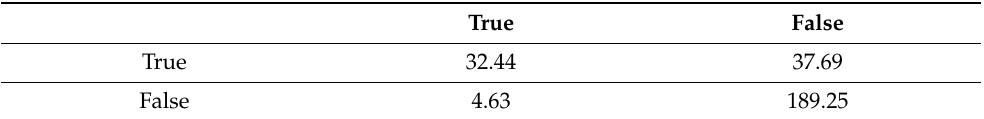
Table 2. The confusion matrix of the evaluation results. As multiple independent evaluations were conducted, the values shown in the table are the average